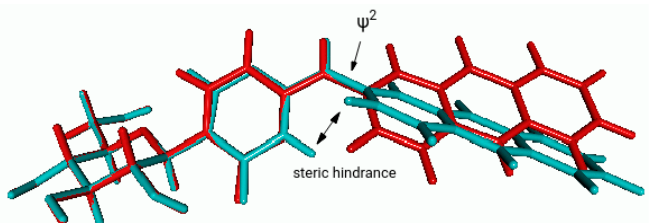
Figure 6. Superimposition of the ψ 1 (s-cis) / ψ 2 (s-trans) conformers of GLAC (red) and Ψ -GLAC (cyan), with the glucose moieties occupying the same space.